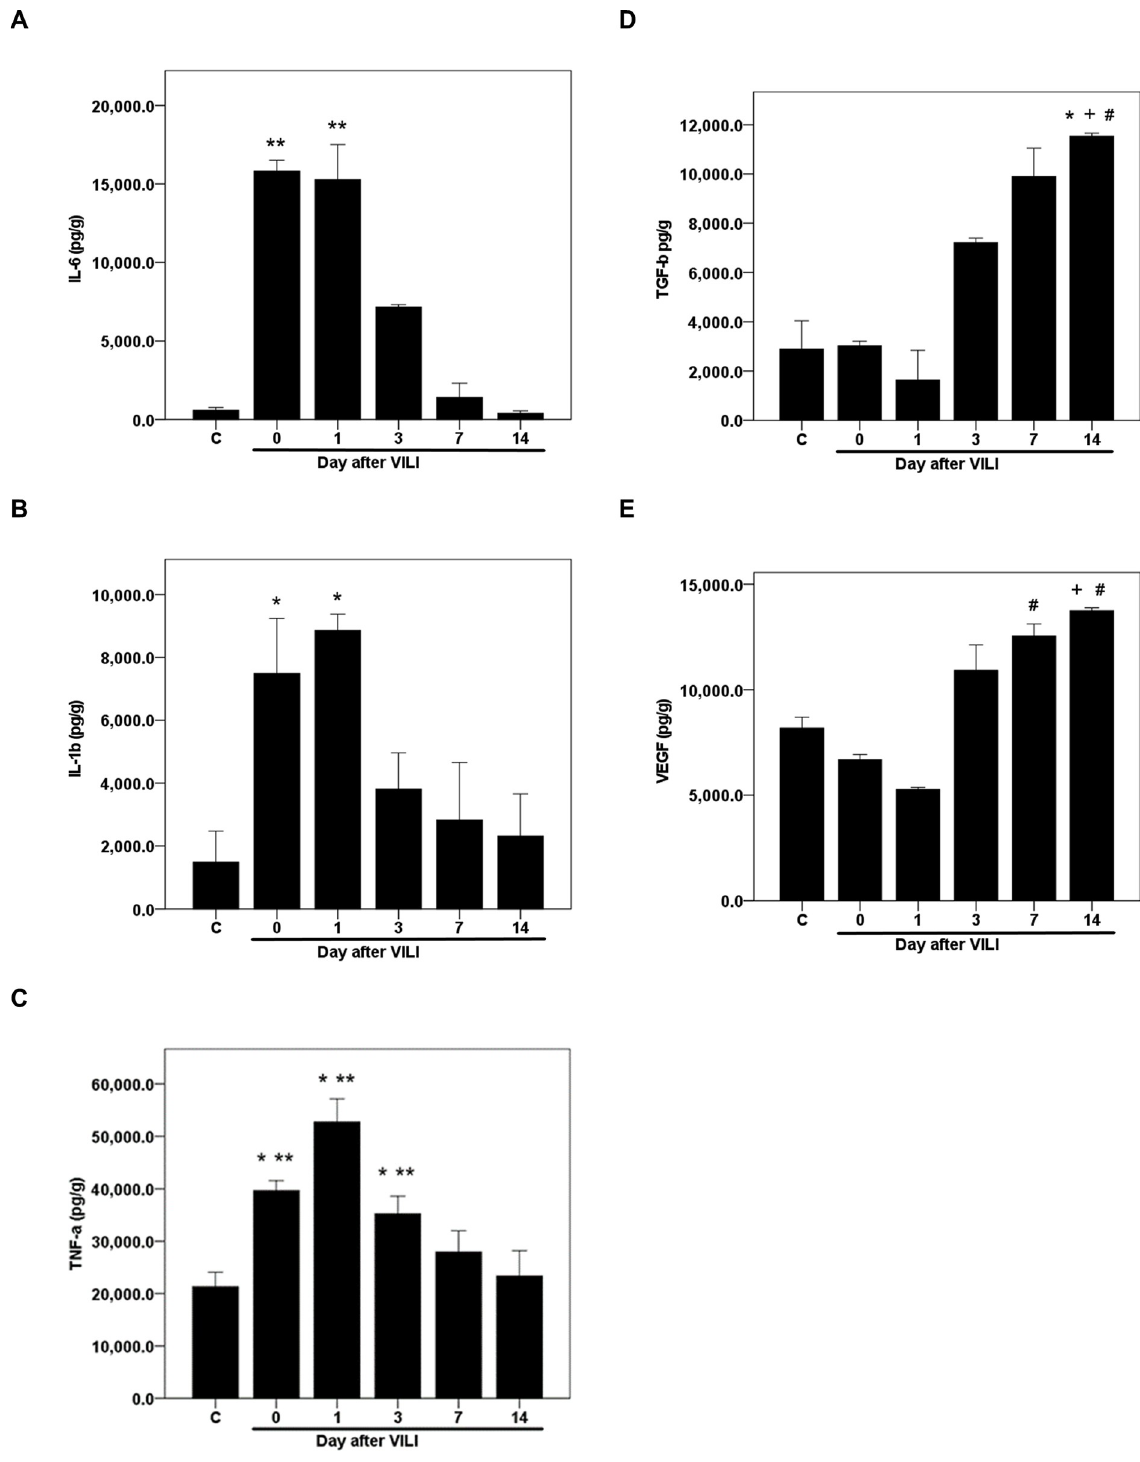
Fig 3. Time courses of pulmonary inflammatory cytokine and growth factor levels following VILI. ELISA for inflammatory cytokines and growth factors in the lung tissue, (A) interleukin-6 (IL-6), (B) interleukin-1 beta (IL-1 β ), (C) tumor necrosis factor-alpha (TNF- α ), (D) tumor growth factor-beta (TGF- β ), and (E) vascular endothelial growth factor (VEGF). Mice were sacrificed immediately after VILI (day 0) or on days 1, 3, 7, or 14 after VILI. Statistical analysis was performed using parametric (one-way ANOVA with Bonferroni’s or Dunnett’s post hoc test) or nonparametric (Kruskal-Wallis test with Bonferroni correction) tests. Data are expressed as means ± SD; n = 4–6 per group, p < 0.05 for � vs. normal control (C), + vs. day 0, # vs. day 1 and �� vs. day 14. https://doi.org/10.1371/journal.pone.0248959.g003 PLOS ONE | https://doi.org/10.1371/journal.pone.0248959 March 19,